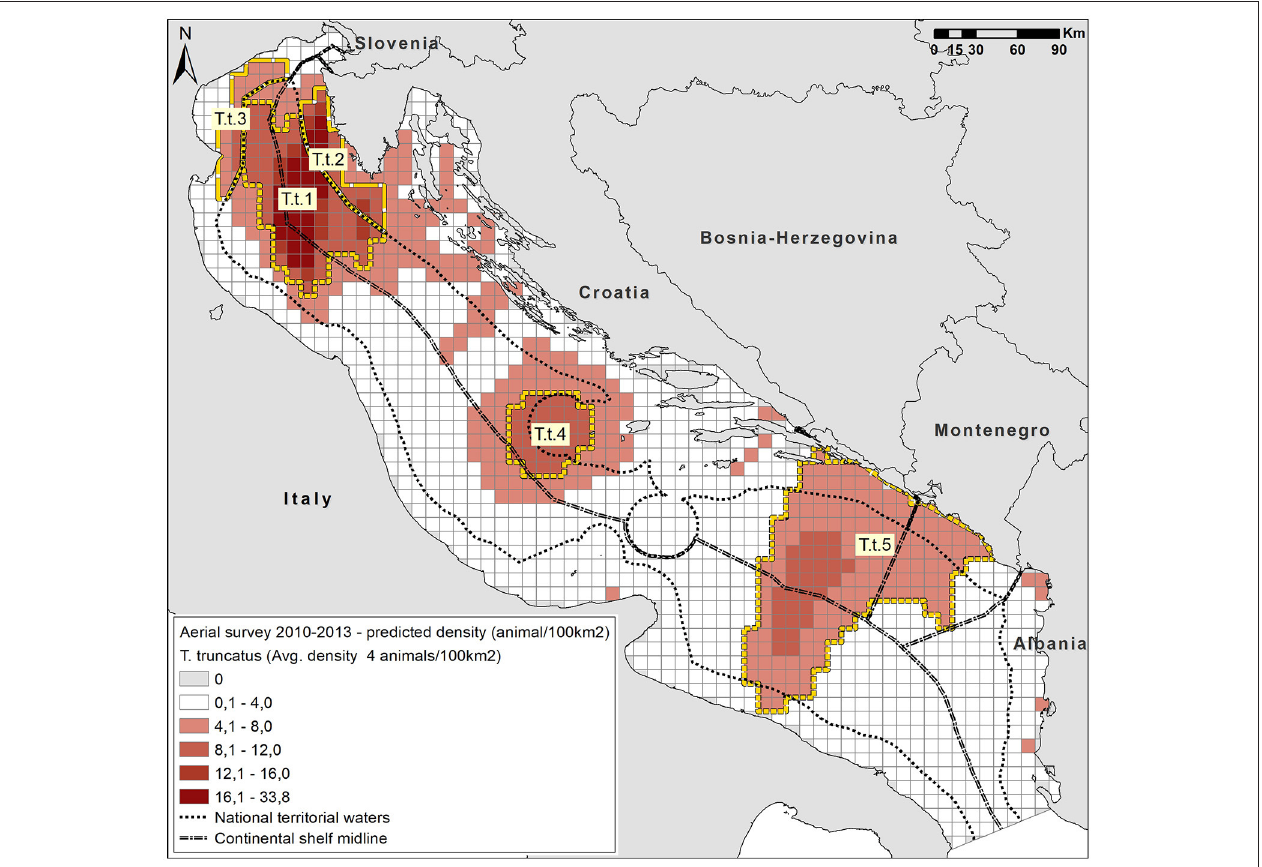
FIGURE 1 | Density Surface predicted distribution of the bottlenose dolphin in the Adriatic Sea based on 2010 and 2013 aerial survey data (darker red scale indicates higher relative density). The scales represent below average (white; L), and then up to twice (L-MD), up to three times (M-HD), up to four times (H-HHD) and greater than four times (MAXD), in shades of dark red. The proposed key areas ( Table 3 ) are identified by yellow dotted (within 12nm), dashed (over 12nm), and dot-dashed shapes (areas within and over